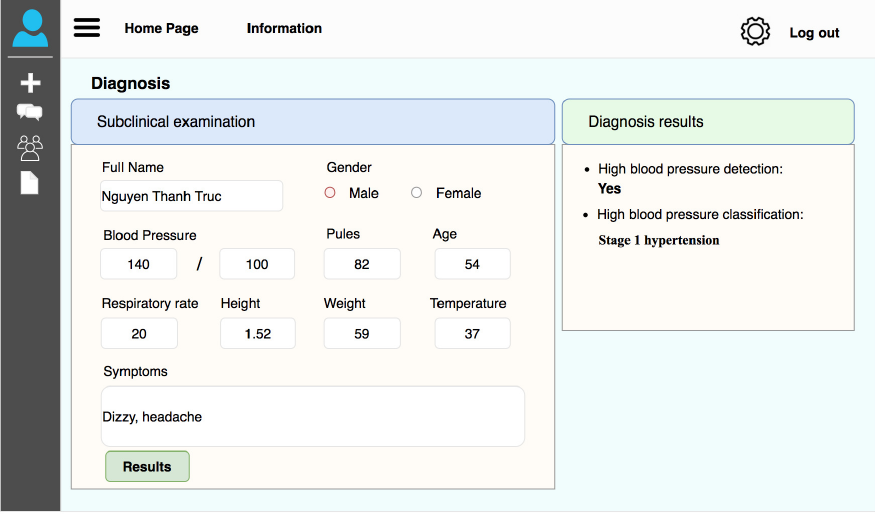
Figure 13. Application of high blood pressure detection and classification.